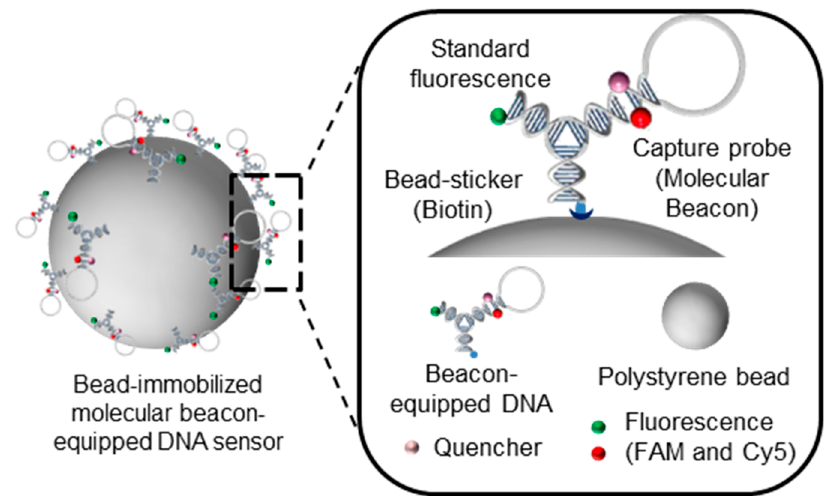
Figure 1. Schematic of the multimodular bead-immobilized molecular beacon-equipped DNA nanosensor. A looped DNA fragment that captures target RNA molecules was added onto a one-component single-stranded DNA molecule.